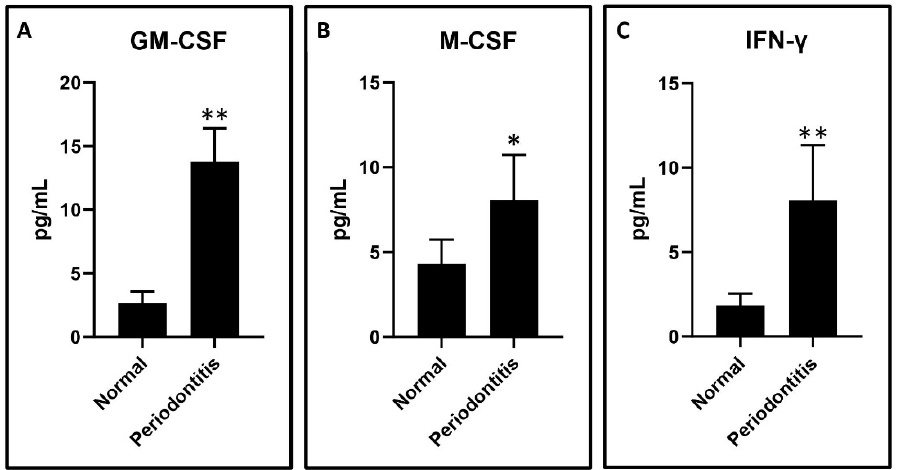
Figure 1. GCF analysis of periodontitis patients versus healthy subjects. ( A )—GM-CSF (** p < 0.0001); ( B )—M-CSF (* p = 0.0238); ( C )—IFN- γ (** p < 0.0001).